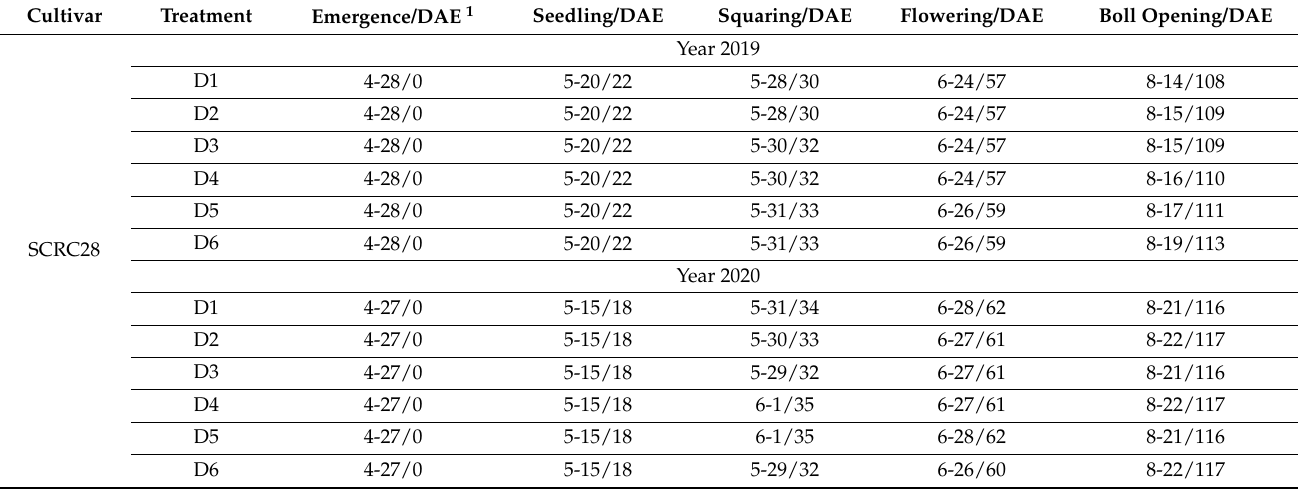
Table 2. Cotton growth stages with different planting densities in 2019 and 2020.